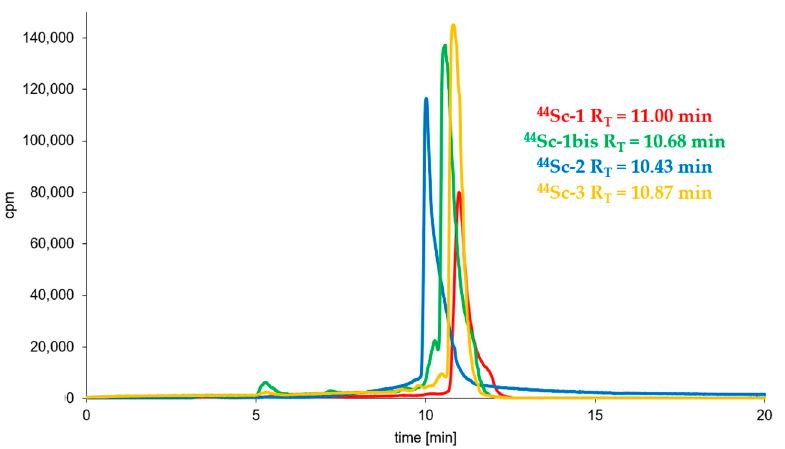
Figure 2. RP-HPLC radiochromatograms of the 44 Sc-1 , 44 Sc-1bis , 44 Sc-3 (System 3) and 44 Sc-2 (System 4) radioconjugates.